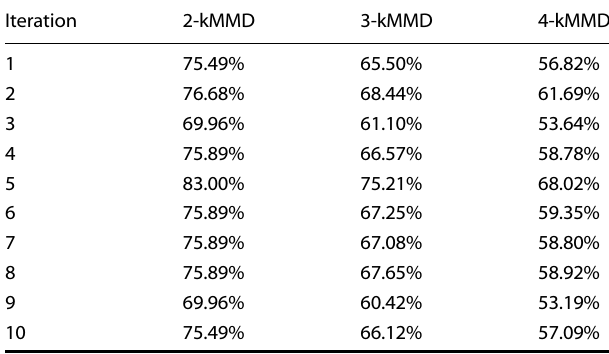
Table 5. Joint distribution tests for 2-, 3-, and 4-variable combinations using kernel